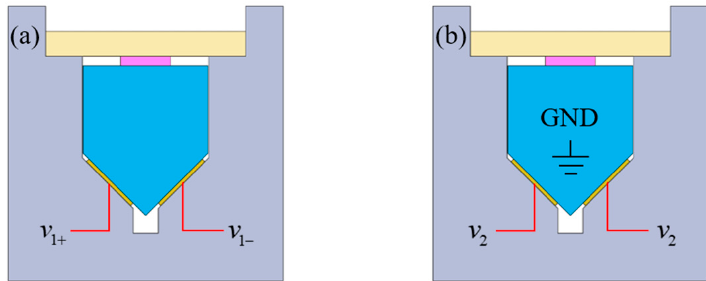
Figure 2. Two schemes for electrostatic adhesion generation: ( a ) scheme A, ( b ) scheme B.